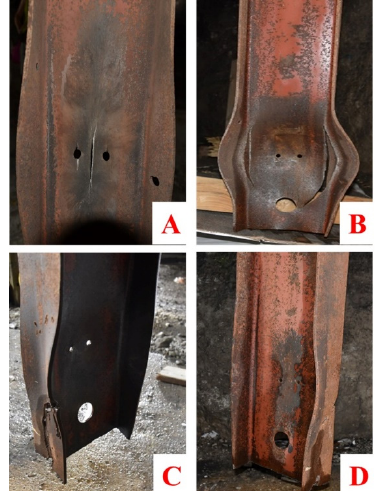
Figure 5. ( A ) damage to the column from the traditional dynamite charge ( B ) Damage to the column from the water ‐ cased charge ( C ): Damage to the column from the half water ‐ cased charge ( D ): Damage to the column from the quarter water ‐ cased charge.